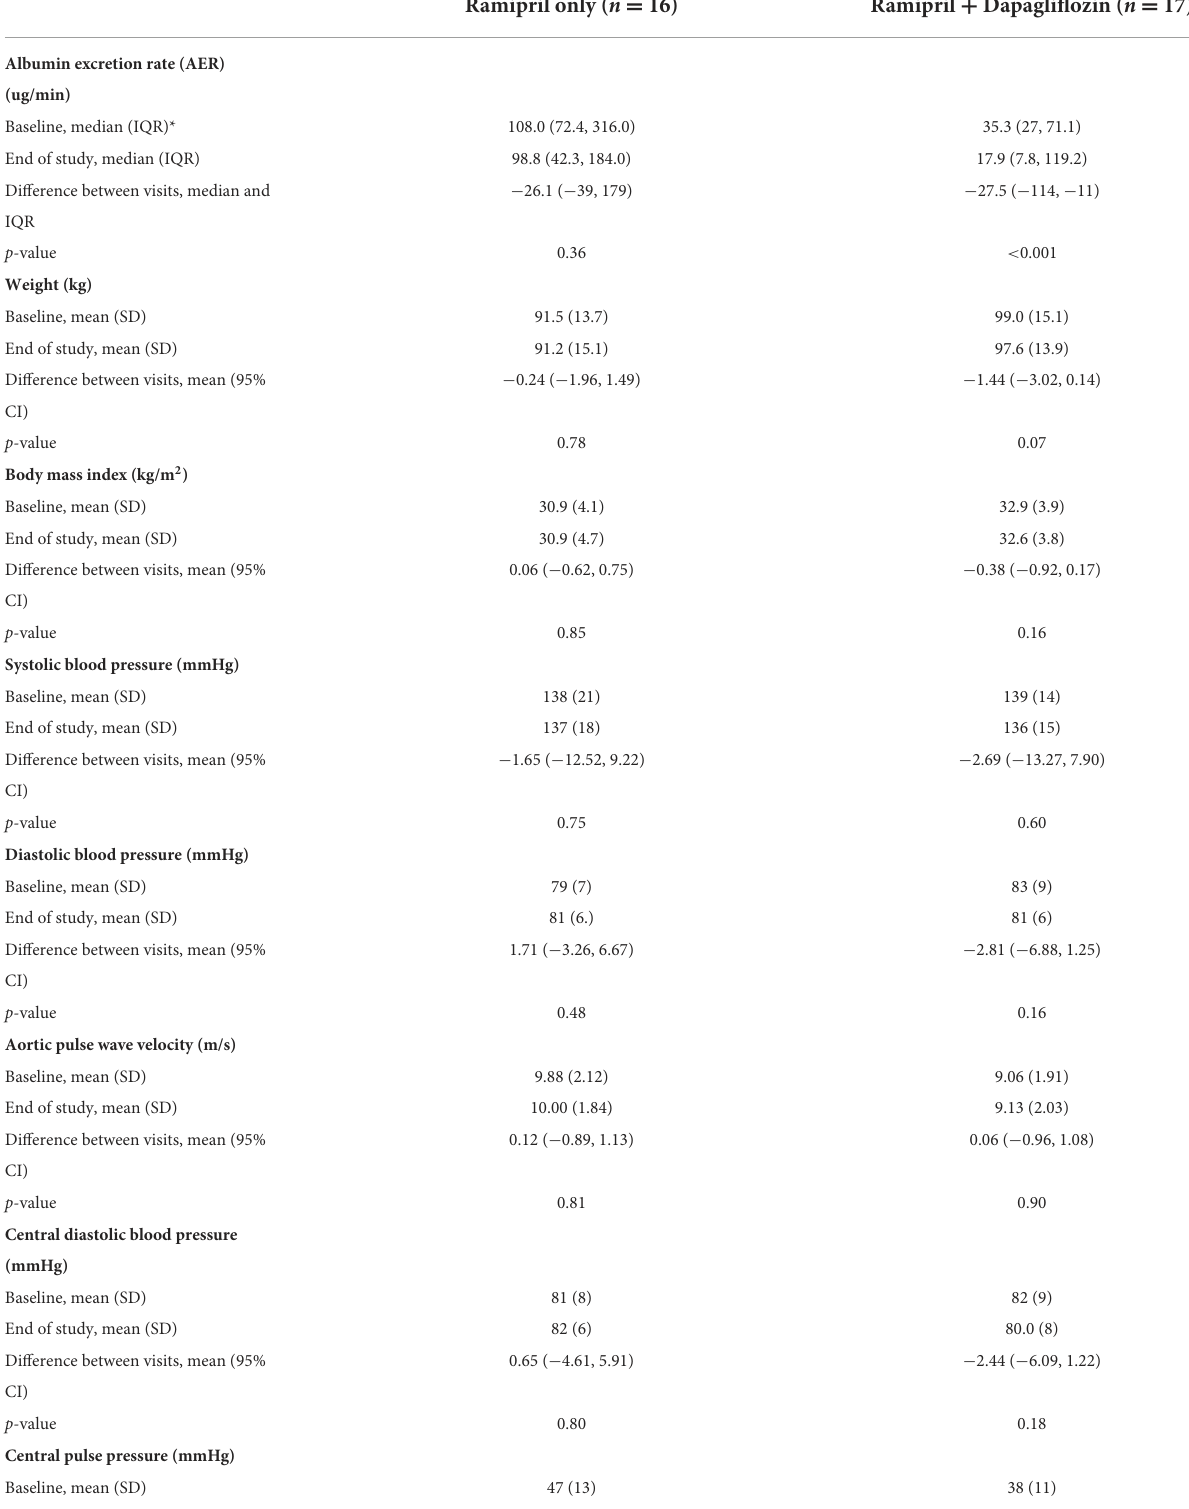
TABLE 2 Changes in primary endpoint and selected secondary endpoint variables (baseline to end of study visit) within Ramipril or Ramipril + Dapagliflozin treatment